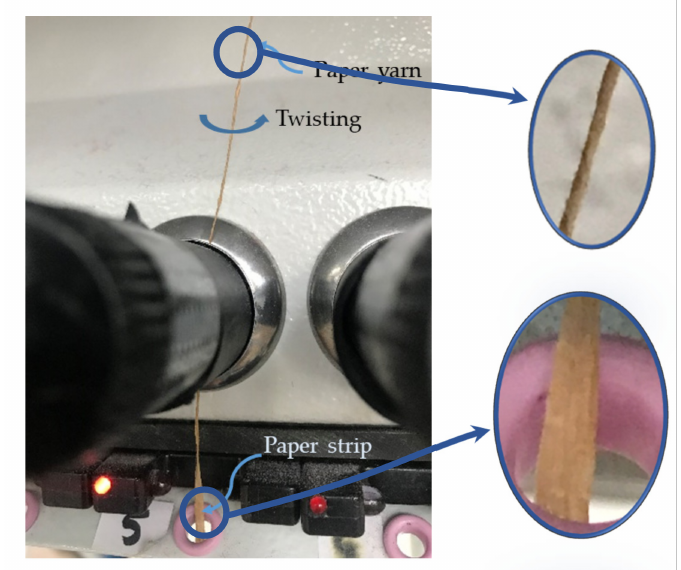
Figure 1. Production of paper yarn from a paper